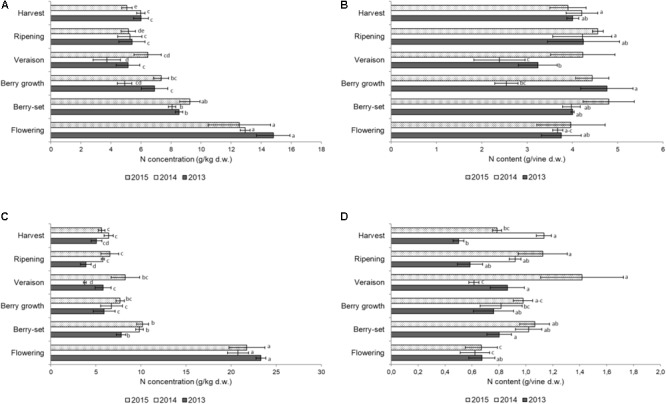
Nitrogen concentration (g/kg of dry weight) in the stems of the primary (A) and secondary (C) shoots and nitrogen content (g per vine) in the stems of the primary (B) and secondary (D) shoots of Italia table grape throughout the seasons of 2013, 2014, and 2015 as a function of the different phenological growth stages. Bars represent standard deviation. For each season, data points followed by a different letter are significantly different at P ≤ 0.05 according to REGQW test. Kruskal-Wallis non-parametric test was used, followed by the Conover-Iman test at P ≤ 0.05, for heteroscedastic values.